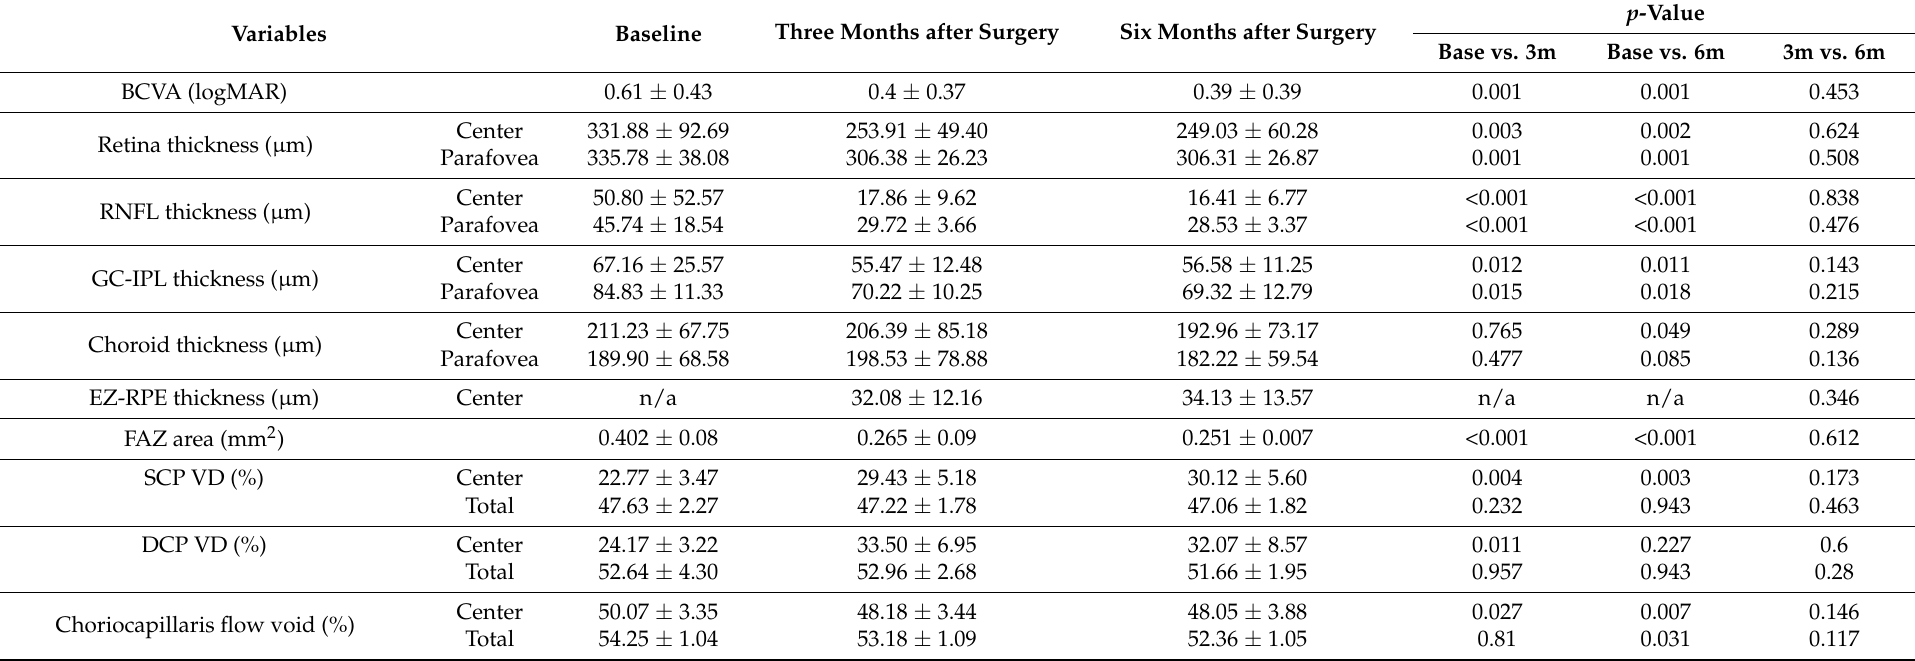
Table 2. Comparisons between the baseline and postoperative BCVA, OCT and OCT-A